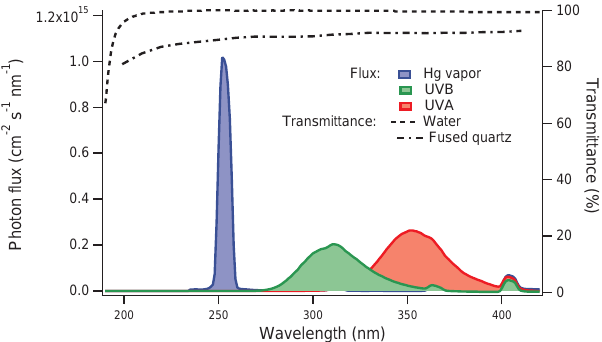
Figure 2. Photon fluxes inside the reactor, as well as the transmit- tance of water and fused quartz (Beder et al.,